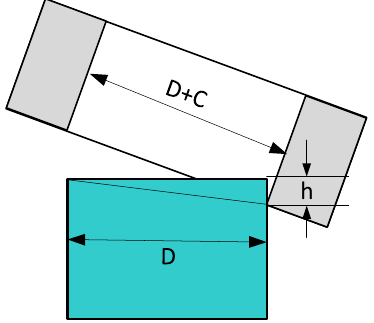
Figure 10. The depth pre-insertion affects insertion process.